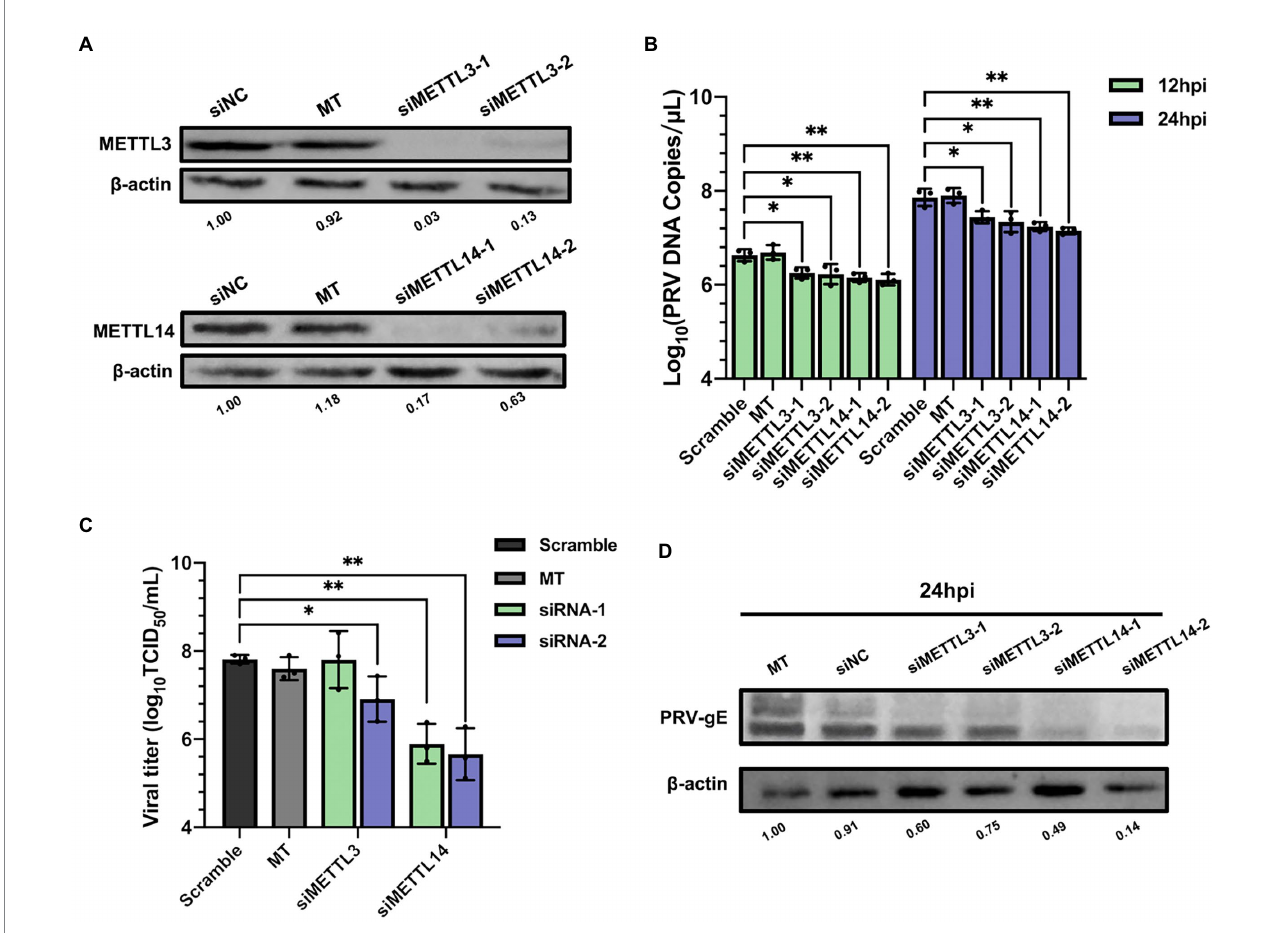
FIGURE 4 Depletion of methyltransferases METTL3 and METTL14 suppressed PRV replication. (A) PK15 cells were transfected with the specified siRNAs (60 nM) for 24 h. METTL3 and METTL14 were assessed by immunoblotting analysis. β -actin was used as a loading control. (B) PK15 cells were transfected with the specified siRNAs and were mock transfected (MT) with transfection reagent alone for 24 h. PK15 cells were infected with PRV-FJ01 (MOI = 0.1) for 12 and 24 h. PRV DNA copies were evaluated by RT-qPCR analysis. (C) PK15 cells were transfected with the specified siRNAs and were mock transfected (MT) with transfection reagent alone for 24 h. PK15 cells were infected with PRV-FJ01 (MOI = 0.1) for 24 h. PRV titers were assessed by TCID 50 analysis. (D) PK15 cells were transfected with the indicated siRNAs and were mock transfected (MT) with transfection reagent alone for 24 h. PK15 cells were infected with PRV- FJ01 (MOI = 0.1) for 24 h. PRV gE was assessed by immunoblotting analysis. β -actin was used as a loading control. * p < 0.05, ** p < 0.01, *** p <